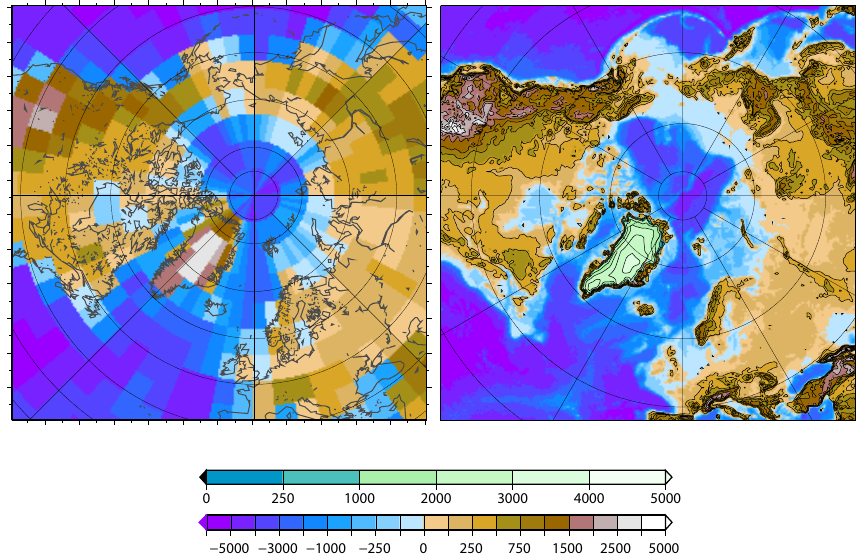
Figure 1. Northern Hemisphere surface topography comparison: ECBilt (a ) and GRISLI (b) . The lower colour scale (in m) indicates the altitude of the topography over non-glaciated areas in GRISLI and everywhere in ECBilt; the upper colour scale shows the altitude of the glaciated areas in GRISLI. The two panels show the restricted area of GRISLI in its Northern Hemisphere